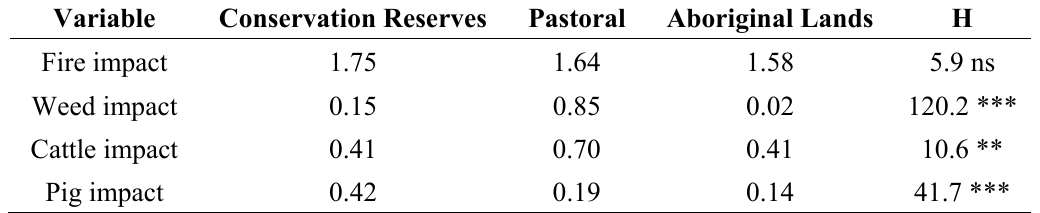
Table 2. Summary table of environmental disturbance variables and their relationship to land tenure. Values in body of table are means (and relate to a scale from 0 (no impact) to